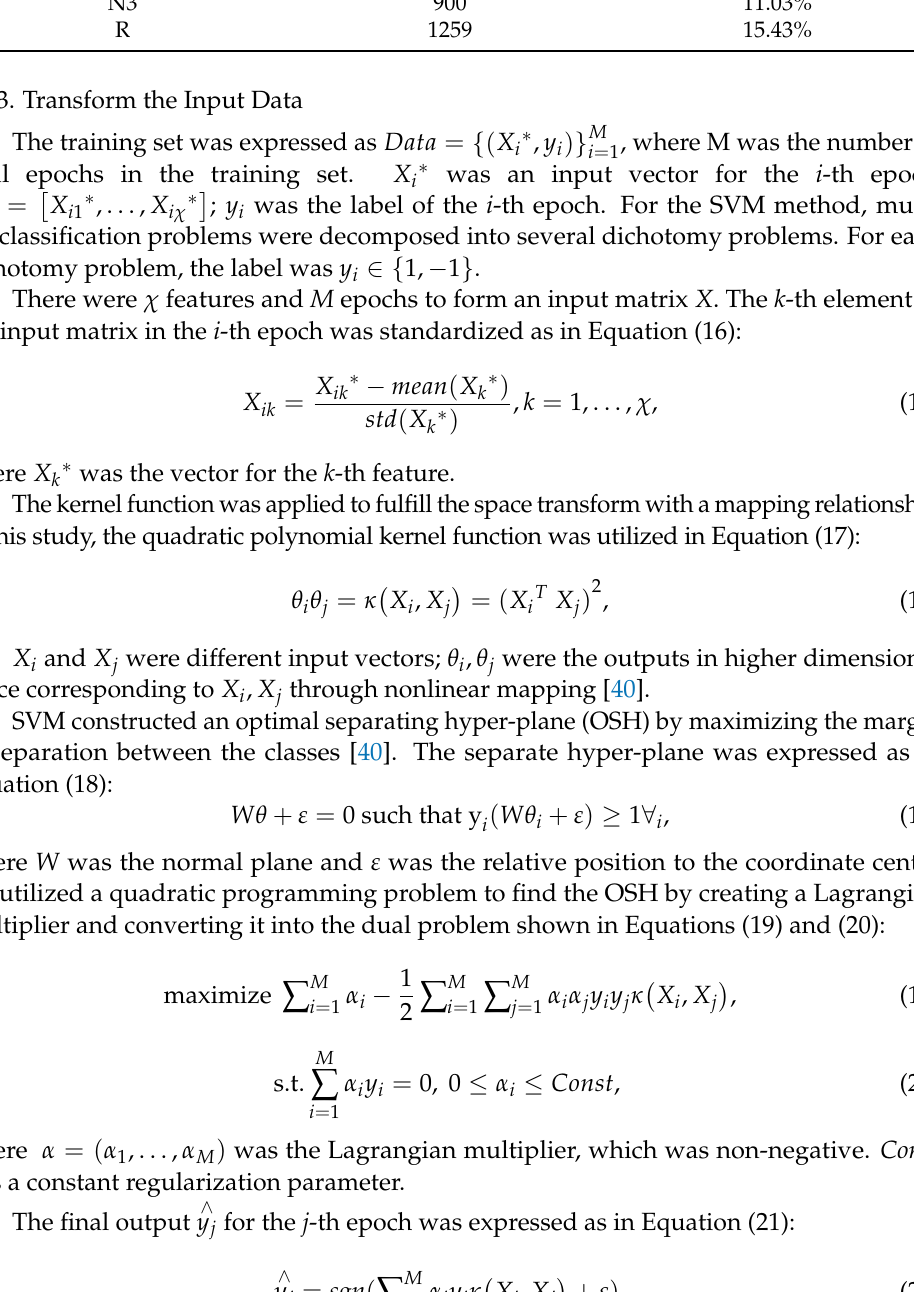
Table 2. The sample size distribution in different sleep stages. Sleep Stage Number of Epochs in Stages Proportion W 2201 26.97% N1 579 7.10% N2 3221 39.47% N3 900 11.03% R 1259